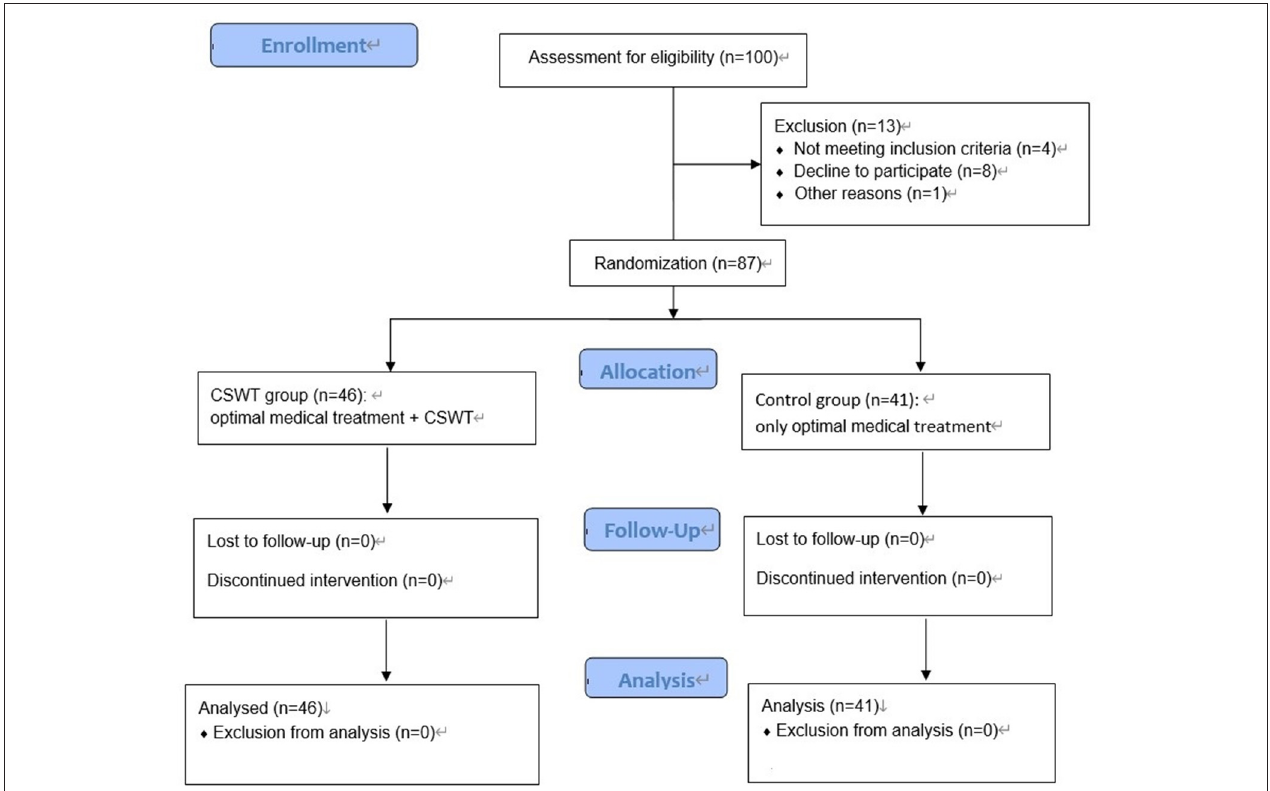
FIGURE 1 | Flowchart of patient recruitment. CSWT, cardiac shock wave therapy; D-SPECT, dynamic single photon emission computed tomography.